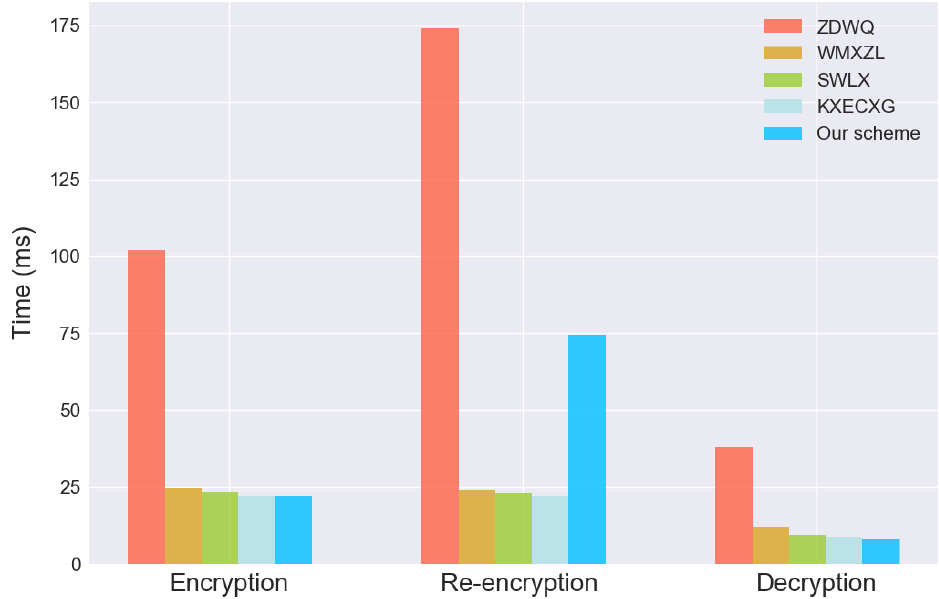
Figure 9. The time-consuming comparison of different stages of data sharing between our scheme and other